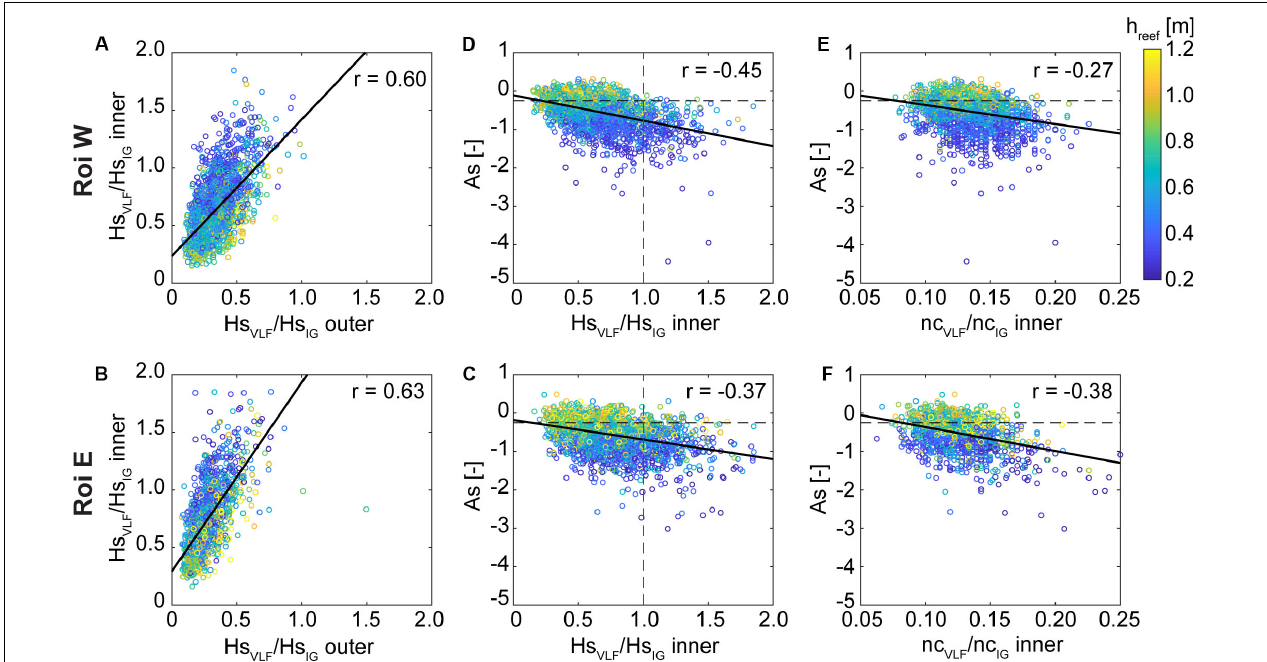
FIGURE 9 | Relationship between very-low-frequency (“VLF”) wave energy and resulting nearshore infragravity (“IG”) wave asymmetry on the Roi-Namur W (Top) and Roi-Namur E (Bottom) reef flats. Color-scale for all panels is the mean reef-flat submergence, h reef . (A,B) Relationship between the VLF and IG wave height ratio ( Hs VLF / Hs IG ) on the outer and inner reef flat. (C,D) Inner reef-flat IG wave asymmetry according to VLF and IG wave height ratio. The threshold of Hs VLF / Hs IG = 1 is indicated by the red dashed line, and the IG bore criterion As = –0.25 is indicated by the black dashed line. (E,F) Inner reef-flat IG wave asymmetry according to ratio of number of VLF wave crests to number of IG wave crests ( nc VLF / nc IG ), cataloged from each individual burst record. The IG bore criterion As = –0.25 is indicated by the black dashed line. For each panel, the correlation coefficient, r , is given (corresponding p < 0.005 for all; degrees of freedom = 1920 for Roi W and 1,323 for Roi E), as well as a linear regression (black line) using an iteratively reweighted least squares with bisquare weighting, to show the